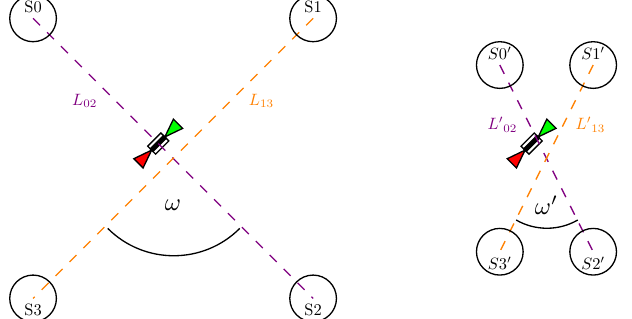
Figure 5. Two possible target arrangements. The left depicts an optimal placement with high target distances L 02 and L 13 as well as an angle between them of ω = 90 ◦ . For the arrangement on the right, however, the targets are close to the LiDAR and an there is an angle ω (cid:48) (cid:54) = 90 ◦ between L (cid:48) 02 and L (cid:48) 13 . The latter is expected to lead to suboptimal calibration